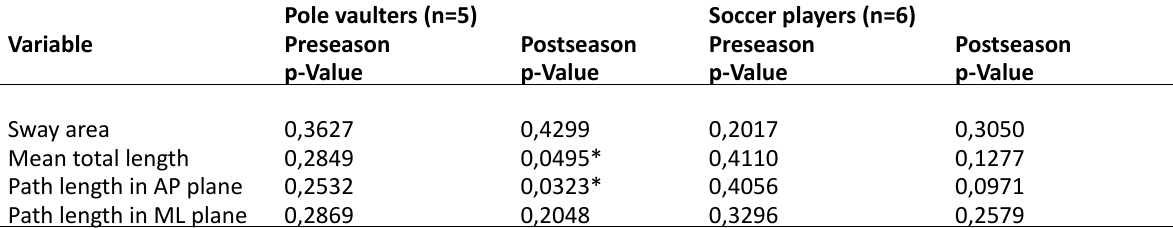
Table 3. Influence of vision on balance control in pole vaulters and soccer